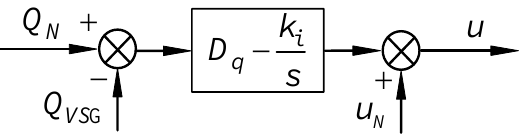
Figure 4. The virtual excitation regulator of VSG.